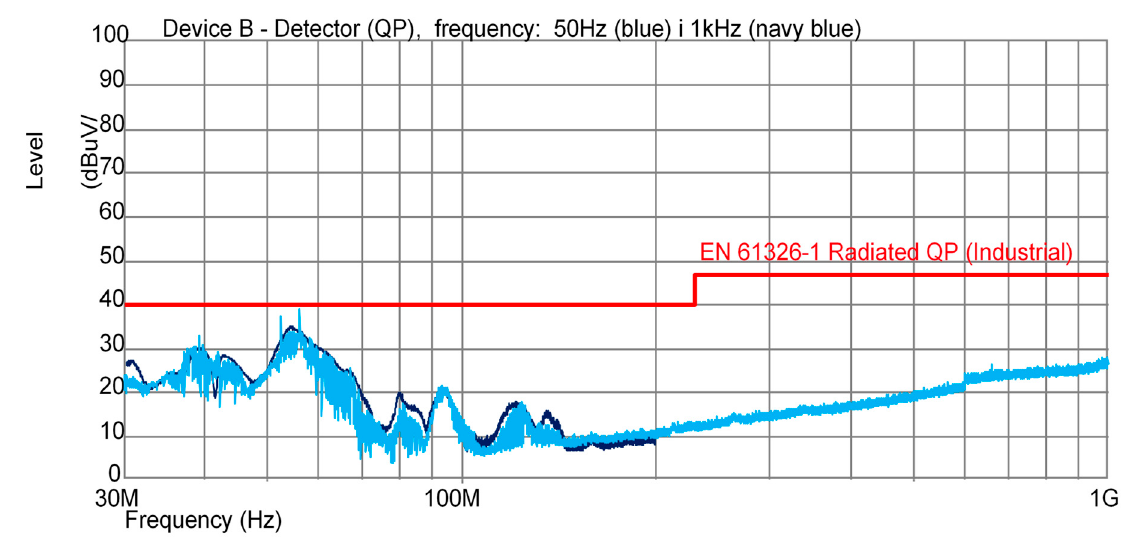
Figure 8. Frequency spectrum of radiated emission of audio power amplifier (device B) for frequencies of generated voltage by the device under test equal to 50 and 1000 Hz.